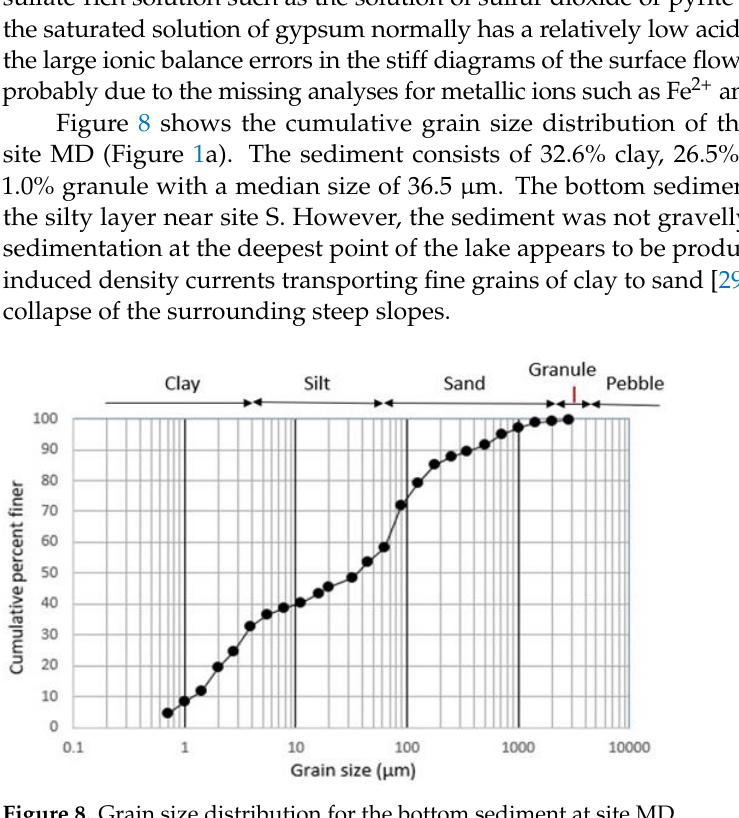
Figure 7. ( a ) Grain size distribution for a silty layer and ( b ) gypsum crystals, contained in the silty layer, on a stainless sieve.